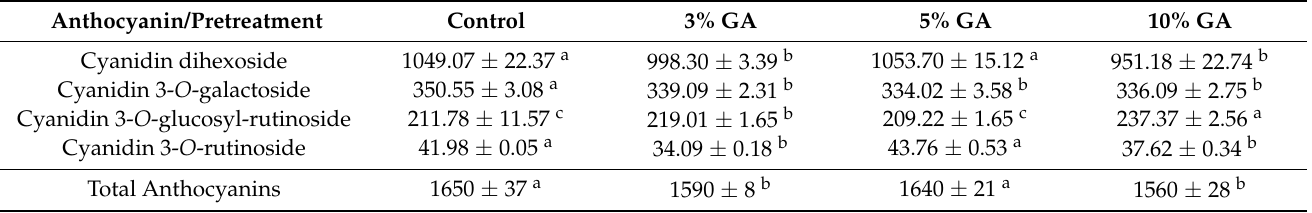
Table 4. Anthocyanin concentration ( µ g/g DM) of the control, GA-pretreated, and oven-dried (60 ◦ C for 18–24 h)